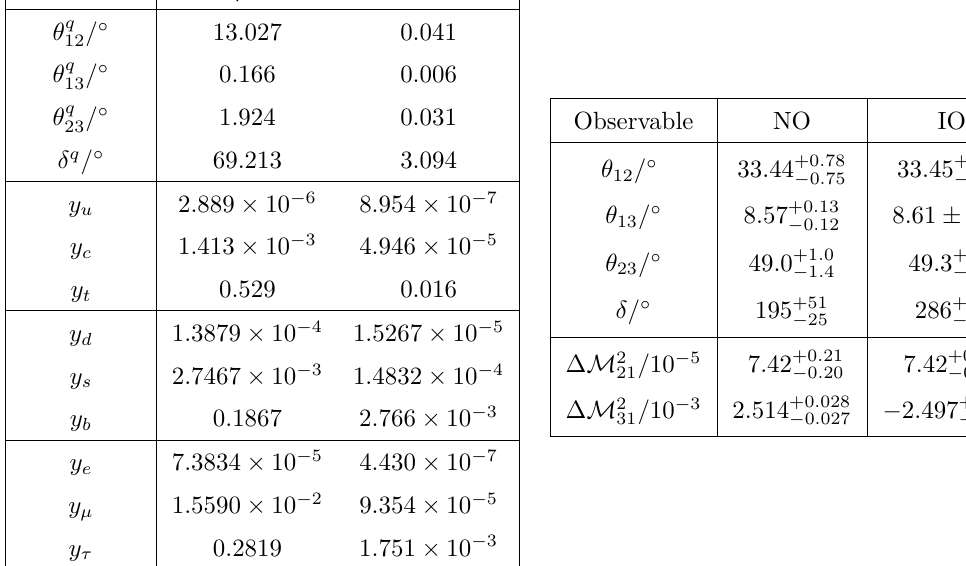
Table 4 . Left panel: the Observables of charged fermions at the GUT scale for tan (cid:12) = 35 are taken from [64]. The SUSY breaking scale are set at M SUSY = 1 TeV and the threshold correction parameters (cid:22) (cid:17) b = 0 : 13125 and (cid:22) (cid:17) q = 0 : 3. Right panel: the values of neutrino Observables are taken from NuFit5.0 [77] without the atmospheric data from SuperKamiokande. NO (IO) denotes the Normal (Inverted) Ordering of neutrino